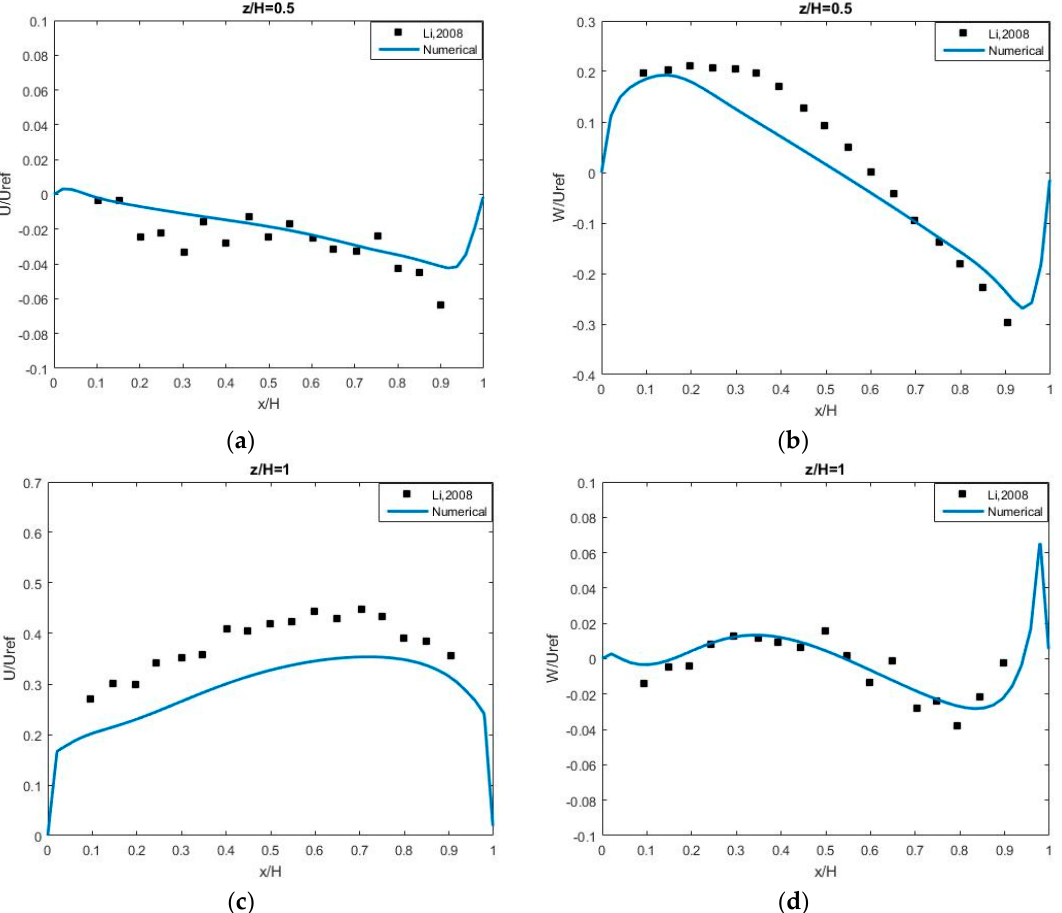
Figure 10. The vertical profile of stream-wise velocity ( a , c ) at center height (z / H = 0.5), and vertical velocity ( b , d ) roof height (z / H = 1) with AR = 1.